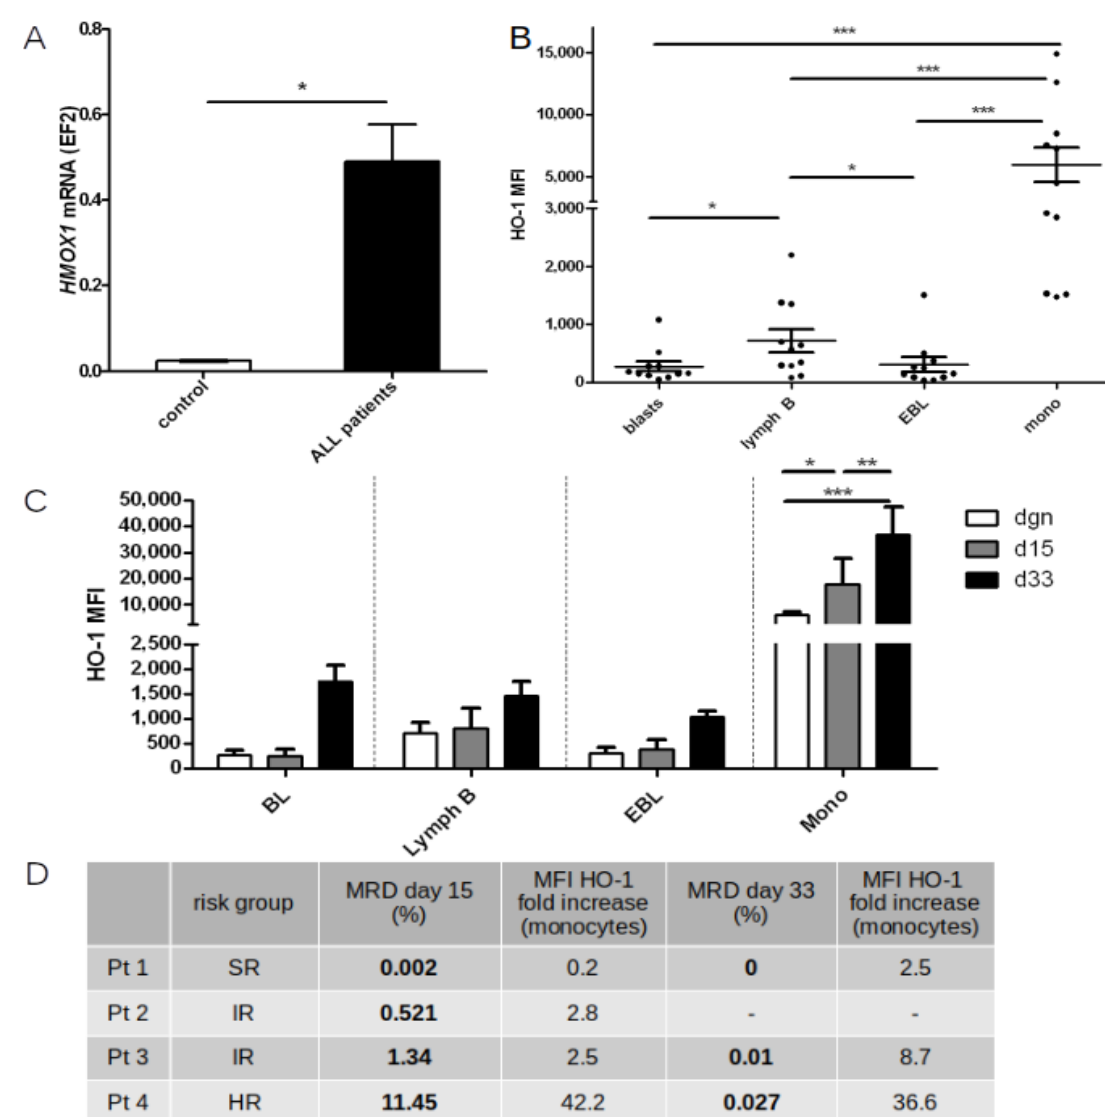
Figure 7. ( A ) Comparison of HMOX1 mRNA level in peripheral blood samples taken from healthy, untreated children ( n = 3) and from ALL children ( n = 19) during treatment course, at stage of clinical remission when no blast cells were found in the blood, and complete blood count was normalized. ( B ) Basal HO-1 expression (shown as MFI) in leukemic cells and the residual normal cell subsets present in the sample at the day of diagnosis ( n = 11). ( C ) MFI of HO-1 in each cell subset before treatment ( n = 11) and at day 15th ( n = 6) and 33rd ( n = 3) of induction. ( D ) The fold increase of HO-1 expression in monocytes in relation to the risk group and to treatment response, expressed as MRD level. Blasts—leukemic cells, lymph B—mature lymphocytes, EBL—erythroblasts, mono—monocytes. *— p < 0.05; **— p < 0.01; ***— p <